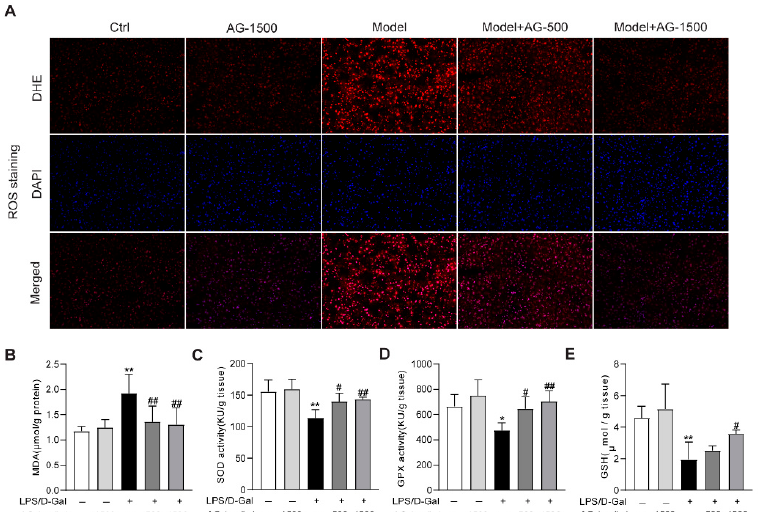
Figure 3. Antioxidant effects of Ala-Gln in liver tissues from mice that received LPS/D-Gal injection. ( A ) ROS detection via DHE staining (original magnification, ×200) in liver tissues. (B ) Hepatic MDA levels. ( C ) Hepatic SOD activities. ( D ) Hepatic GPX activities. ( E ) Hepatic GSH levels. Data are expressed as mean ± SD, n = 6–8 in each group. * p < 0.05, ** p < 0.01 vs. vehicle-treated control group, # p < 0.05, ## p < 0.01 vs. LPS/D-Gal-treated model group. 3.4. Ala ‐ Gln Regulates the Distribution of Hepatic F4/80 ‐ and CD68 ‐ Positive Immune Cells in the Liver and Attenuates Inflammation